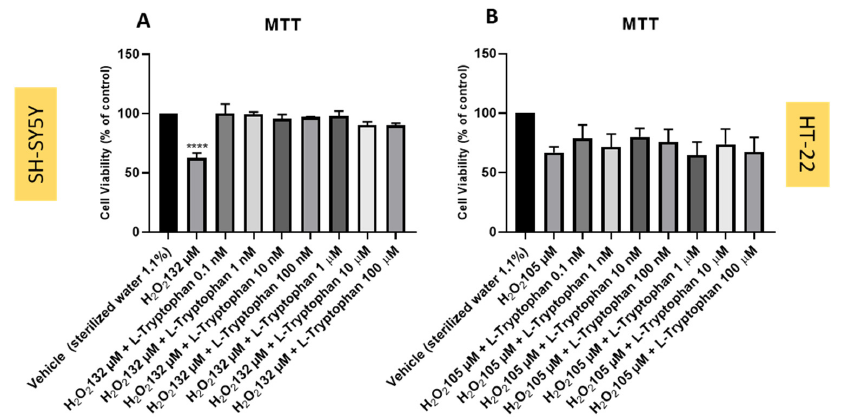
Figure 13. Effect of 48 h-incubation of ( A ) 132 µ M of H 2 O 2 and ( B ) 105 µ M of H 2 O 2, in combination with 0.1 nM–100 µ M of L-tryptophan, determined by MTT methodology. The results represent the mean ± SEM of three independent experiments, expressed as the percentage of the vehicle (100%). Statistically significant **** p < 0.0001 vs.